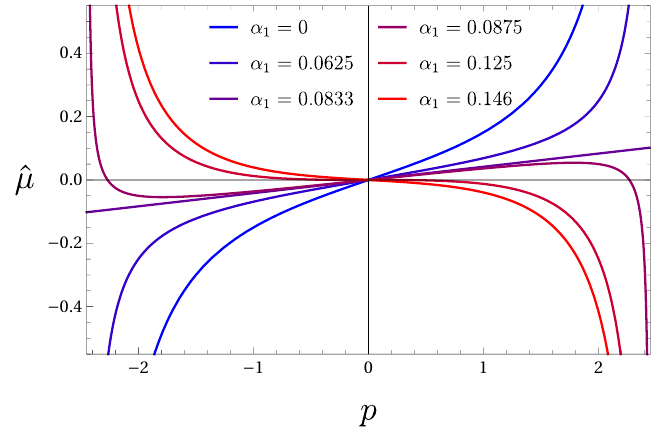
Figure 2. Dimensionless chemical potential ˆ µ as a function of the parameter p for different values of the coupling α and β = 0 , in d = 4 dimensions. Notice that in this case the range (6.40) where 1 ˆ µ ( p ) is non-invertible becomes α (1 / 12 , 1 / 8) 1 ∈